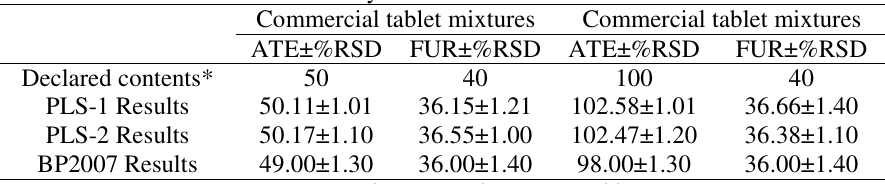
Table 6. Analysis of commercial tablets